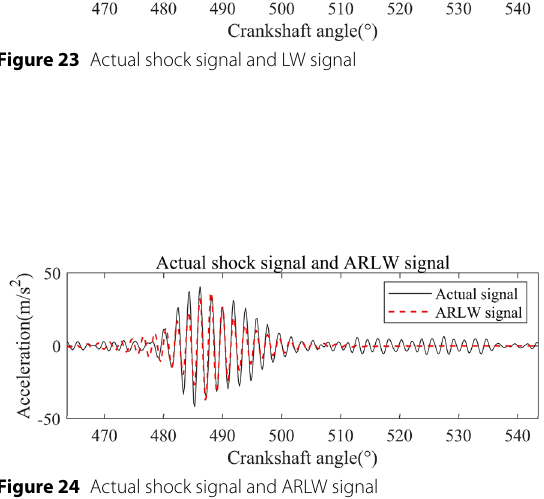
and the valve closing shock start phase is relatively fixed. Thus, the shock start position is a very critical fault fea- ture. From the spectrum analysis (as shown in Figures 17 and 18), the shock frequency band is mainly around